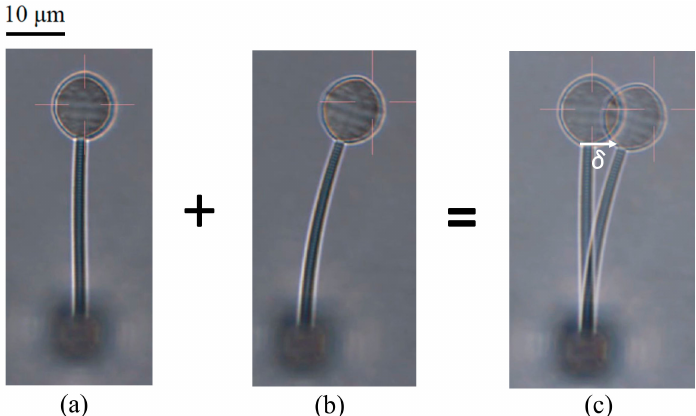
Figure 4. Typical photomicrographs of a bar specimen: ( a ) Before bending; ( b ) during bending and ( c ) superimposed images to measure the deflection δ .